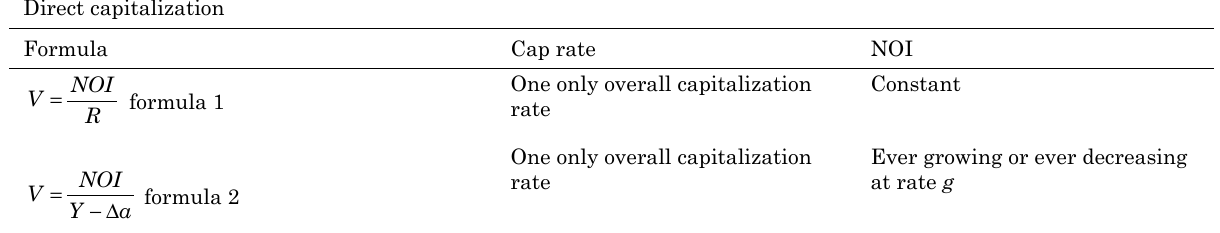
constant ever growing or ever decreasing at rate g